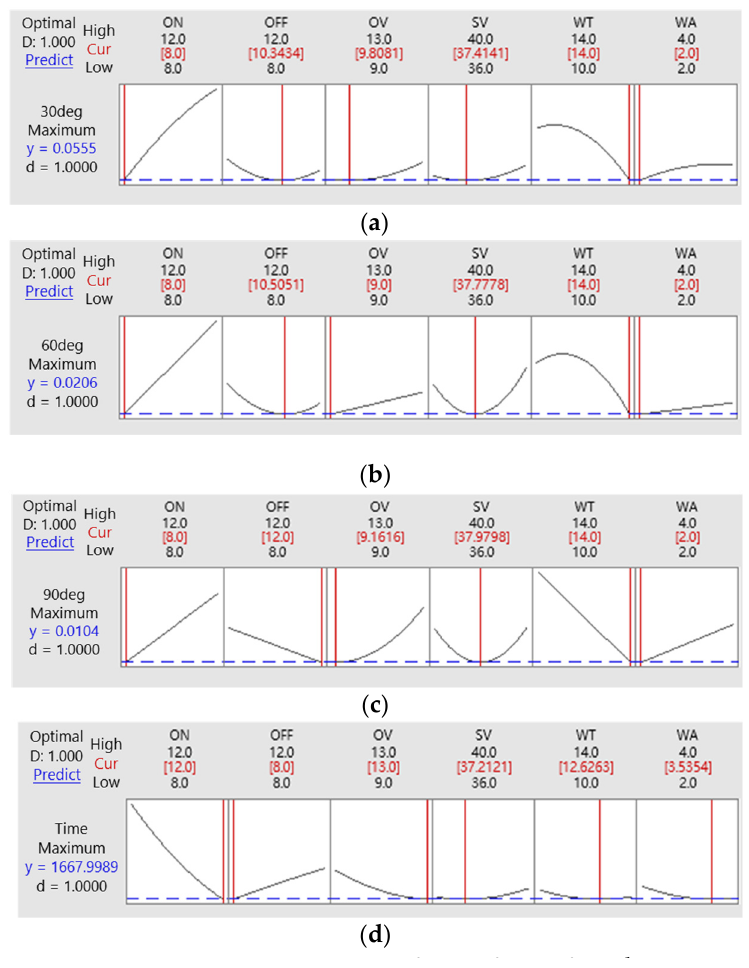
Figure 8. The optimization plot for ( a ) 30 °, ( b ) 60 °, ( c ) 90 °, and ( d ) machining speed.